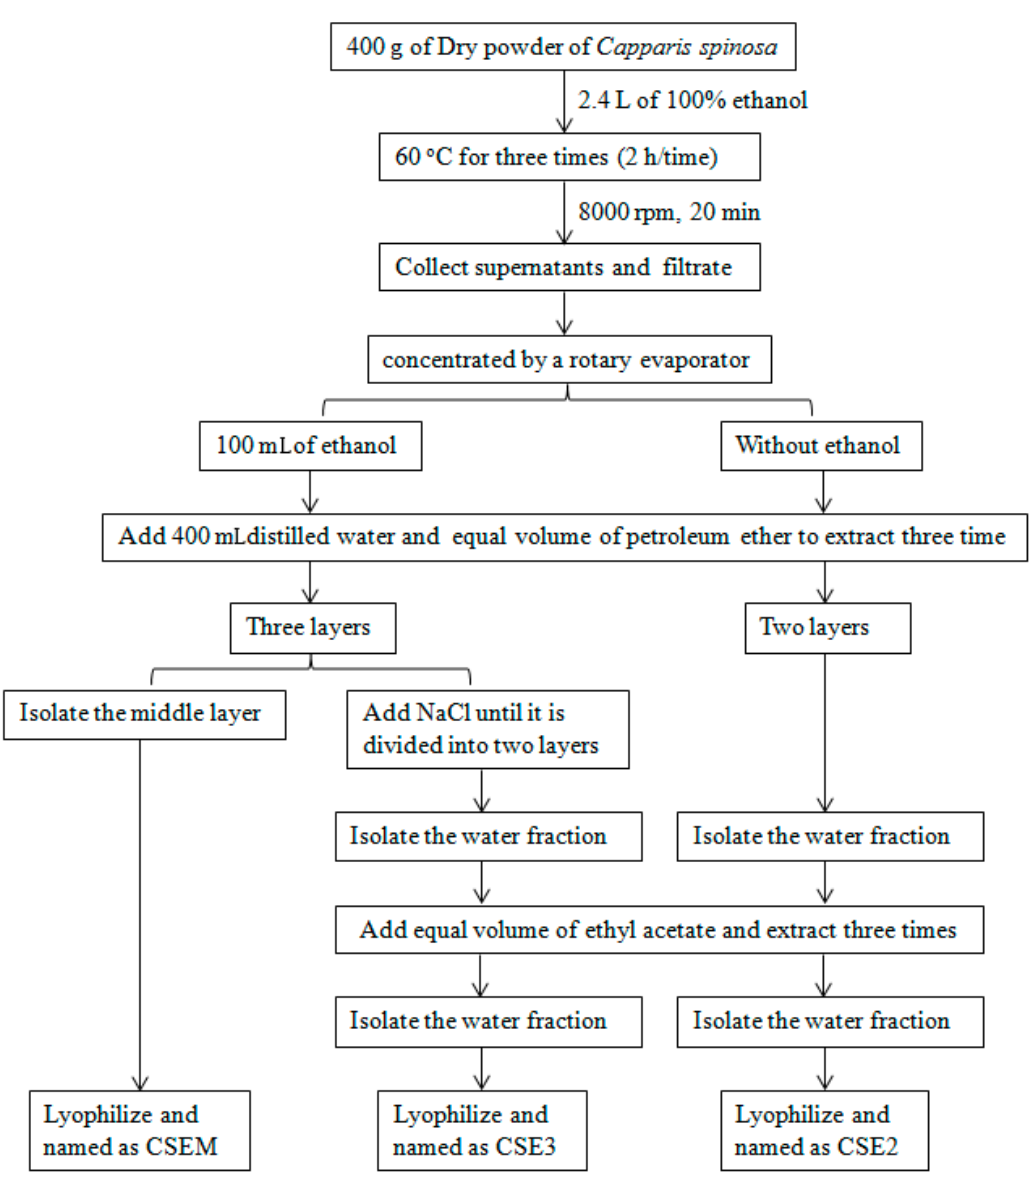
Figure 1. The extraction procedures for CSE2, CSEM, and CSE3. Table 1. Contents of flavonoids and polysaccharides in Capparis spinosa